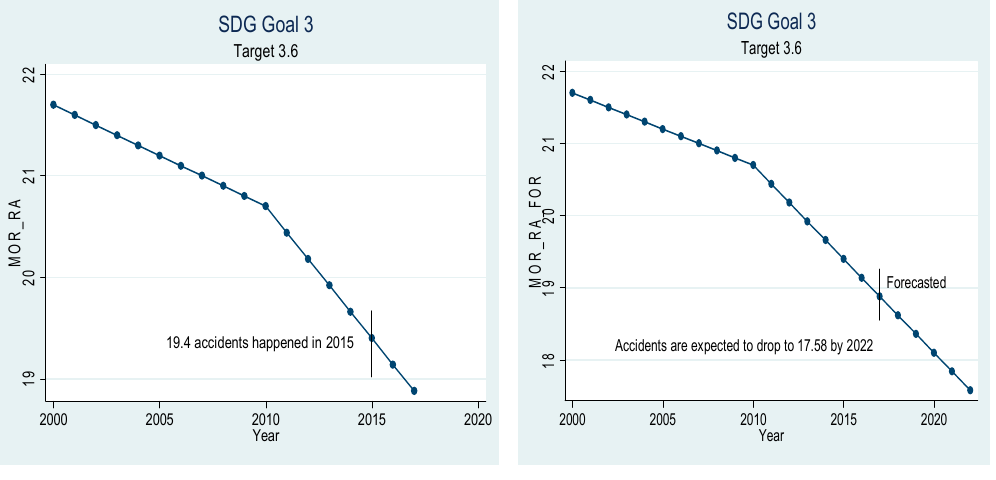
Figure 6. Sustainable development goal 3, target 3.6 (deaths by road accidents) ex-post and ex-ante .